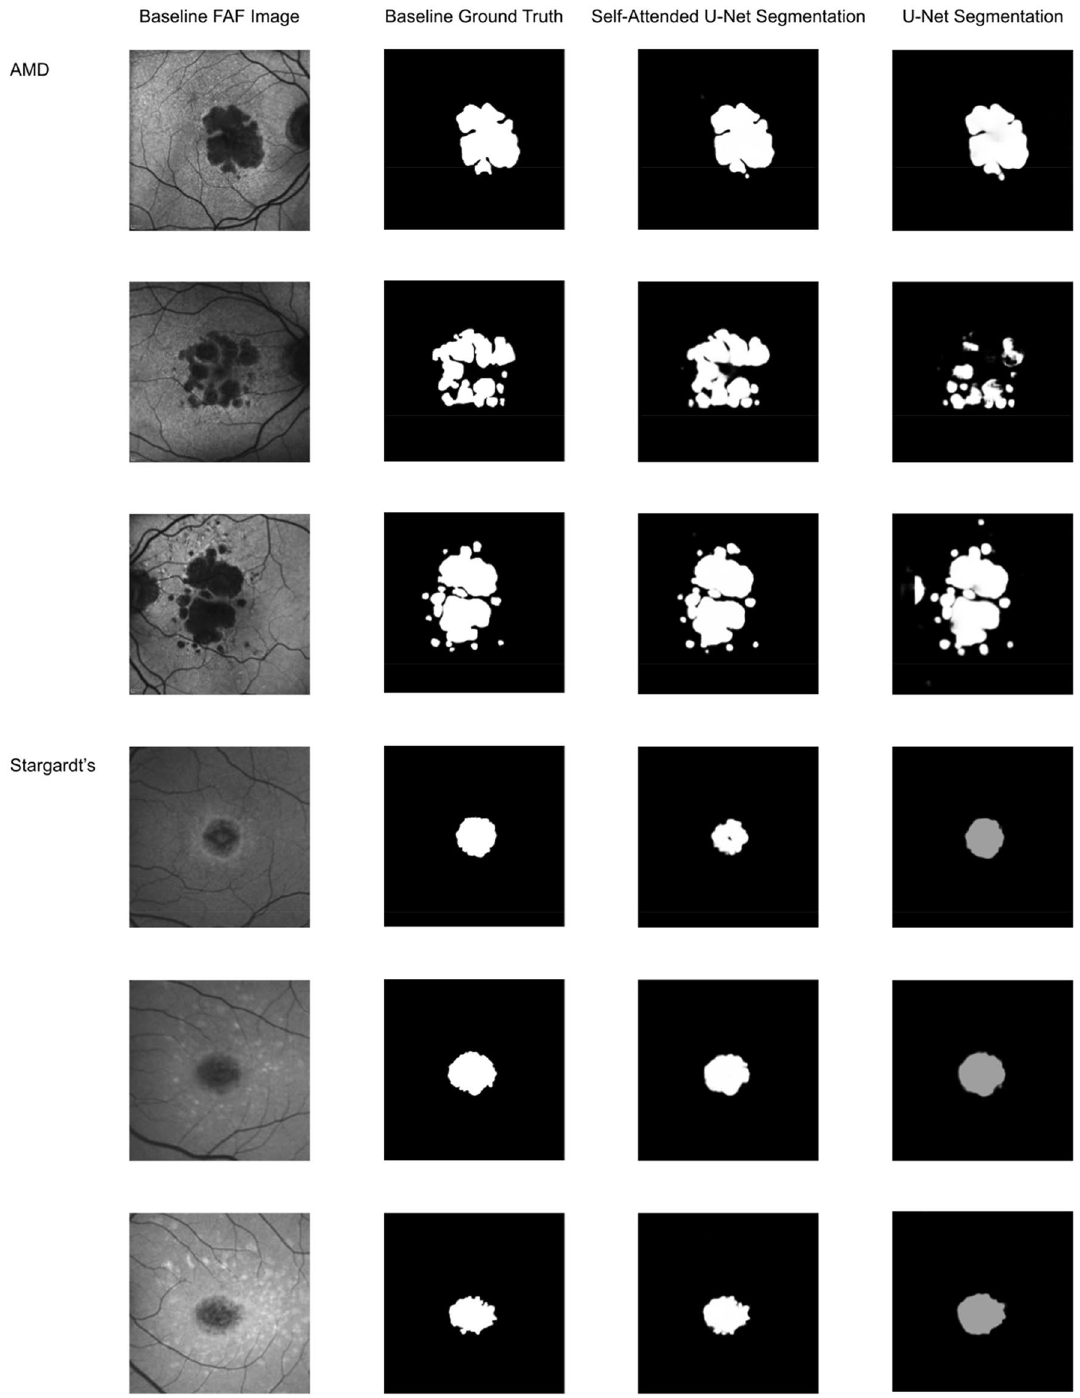
Figure 4. Illustration of atrophy segmentation results of the self-attended U-Net and the regular U-Net on baseline images with a representative